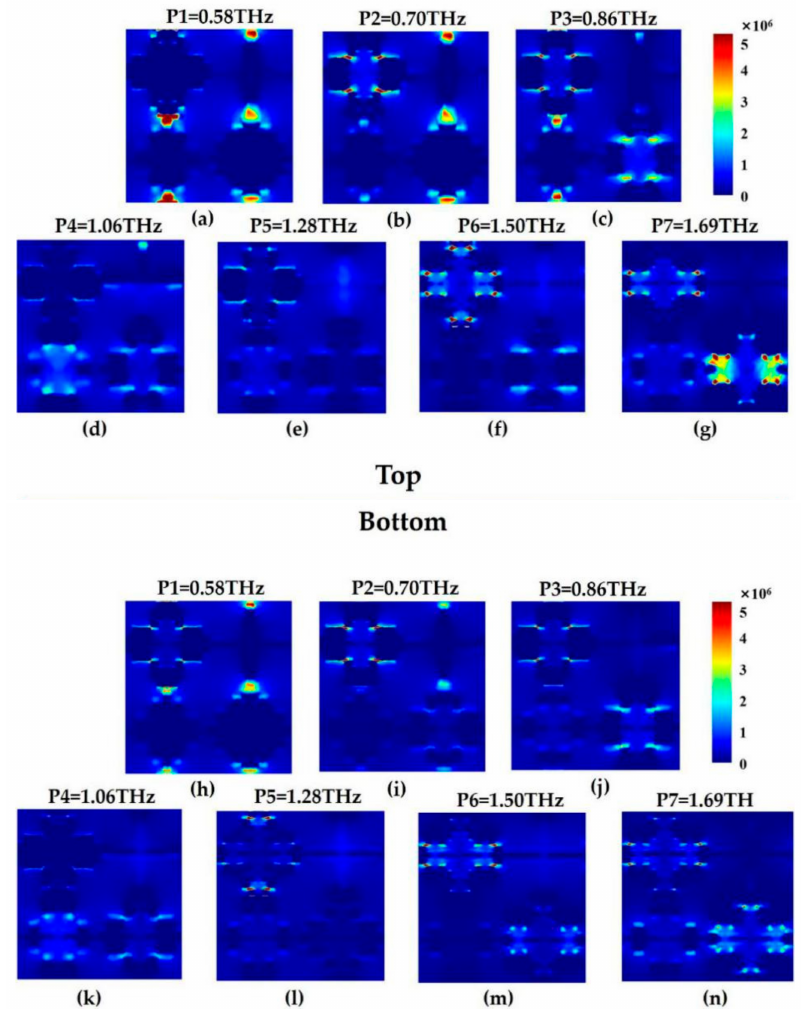
Figure 5. The cross fractals of the top ( a – g ) and bottom ( h – n ) layers of the absorption spectra correspond to the E- field profiles for broadband